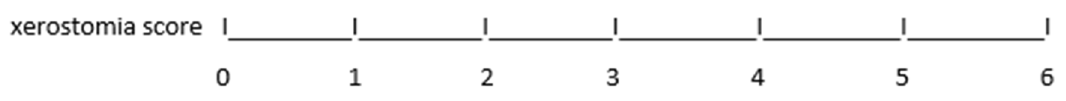
Figure 3. Visual Analogue Scale (VAS) of Xerostomia (0–6).